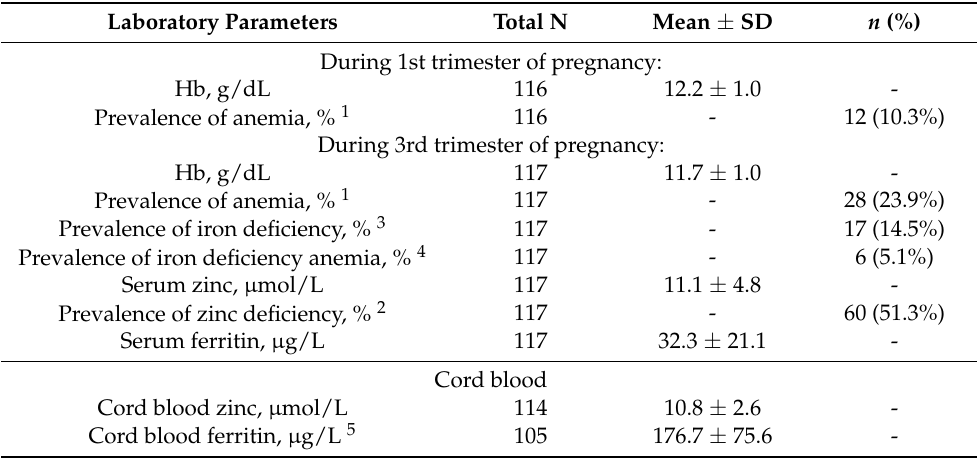
Table 2. Maternal zinc and iron/anemia status during pregnancy and cord blood zinc and ferritin levels Laboratory Parameters